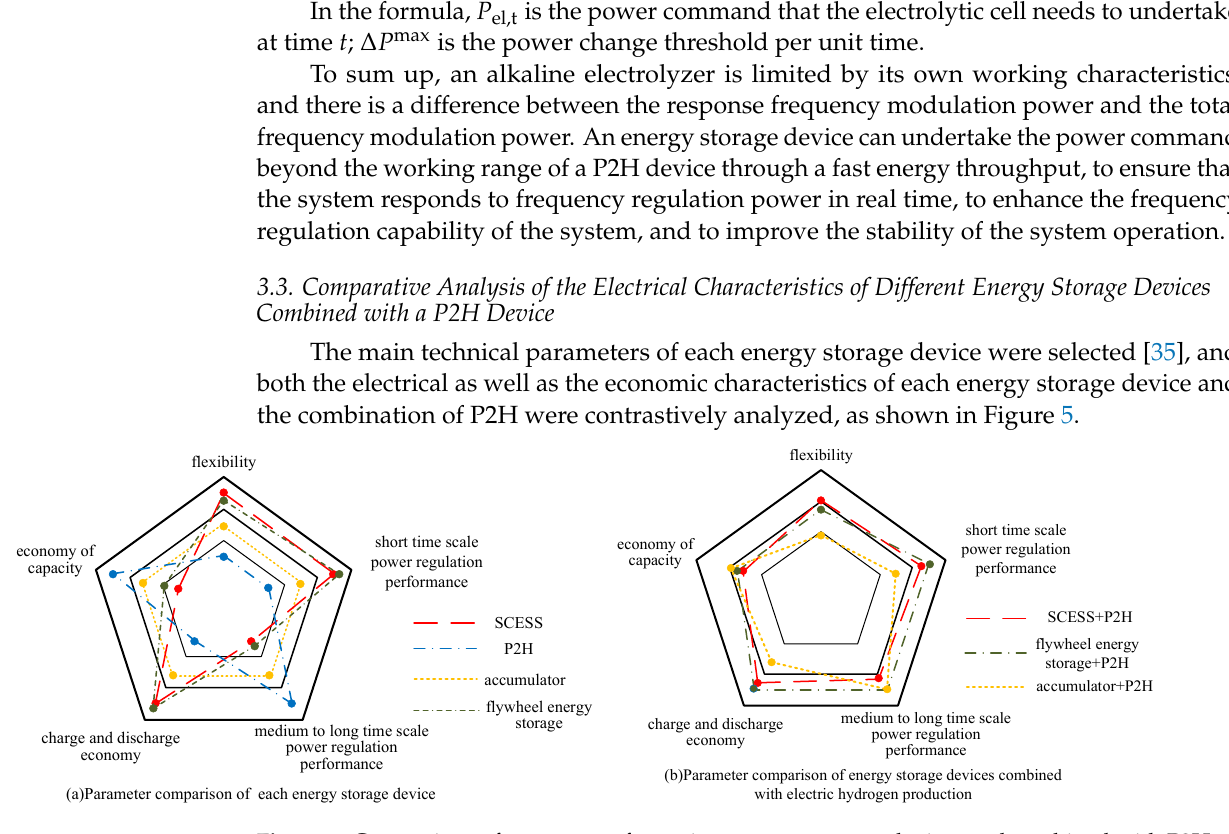
Table 1. Main technical indexes of an alkaline electrolytic cell.